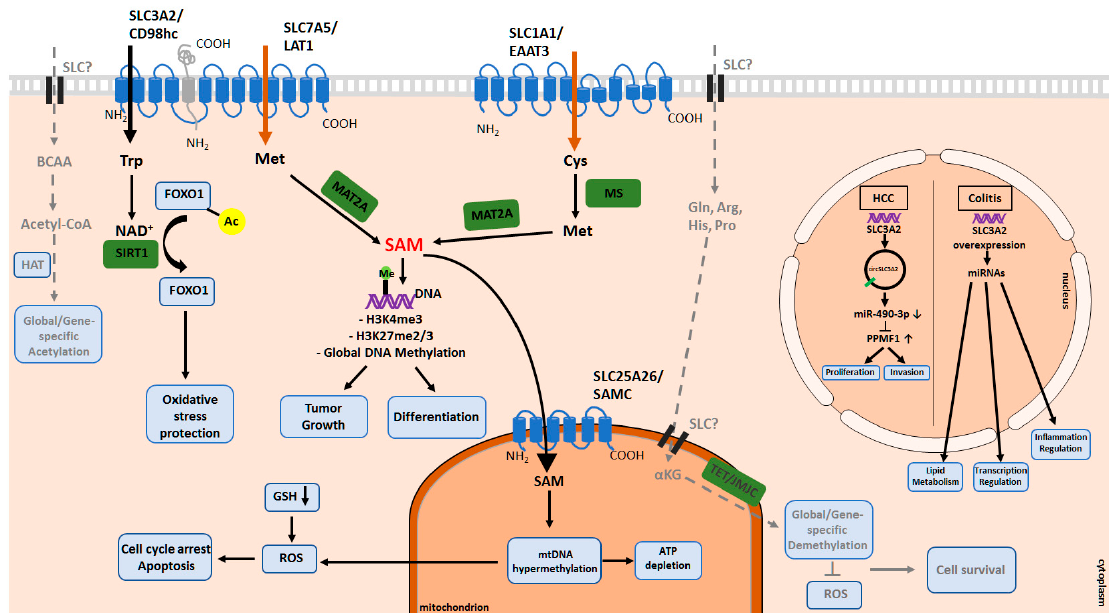
Figure 3. Epigenetic modifications controlled by amino acid transporters. Amino acid transporters play an important role in global or gene-specific epigenetic regulations. The LAT1(SLC7A5)/CD98hc (SLC3A2) complex is among the amino acid transporters responsible for Trp and Met uptake. SAM is produced from intracellular Met by MAT2A and is used as a methyl donor for methylation reactions. SLC1A1/EAAT3 is among the regulators of methylation reactions through Cys uptake, which is subsequently converted to Met by MS. SAM can be transported into mitochondria by SAMC, a mitochondrial carrier which was shown to be important for mtDNA hypermethylation and subsequently intracellular ROS levels. Intracellular tryptophan, which is transported by SLC7A5, is used for de novo NAD+ production and intracellular NAD+ levels control the activity of HDACs. In the presence of NAD+, SIRT1 removes the acetyl group and inactivates FOXO1, a transcription factor, and a critical cellular redox sensor protecting the cell from oxidative stress. In colitis, SLC3A2 overexpression results in increased miRNA-132 expression levels and consequently, downregulation of its target genes that are involved in different pathways, including lipid metabolism, transcriptional regulation and inflammation regulation. circSLC3A2, a circular RNA encoded by SLC3A2, induces proliferation and invasion in HCC by sponging miR-490-3p and regulating PPM1F expression. Amino acid transporters regulating the demethylation or acetylation reactions remain to be determined. Acetyl-CoA: Acetyl Coenzyme A; Ac: Acetylation; α KG: Alpha-ketoglutarate; Arg: Arginine; Cys: Cysteine; Gln: Glutamine; GSH: